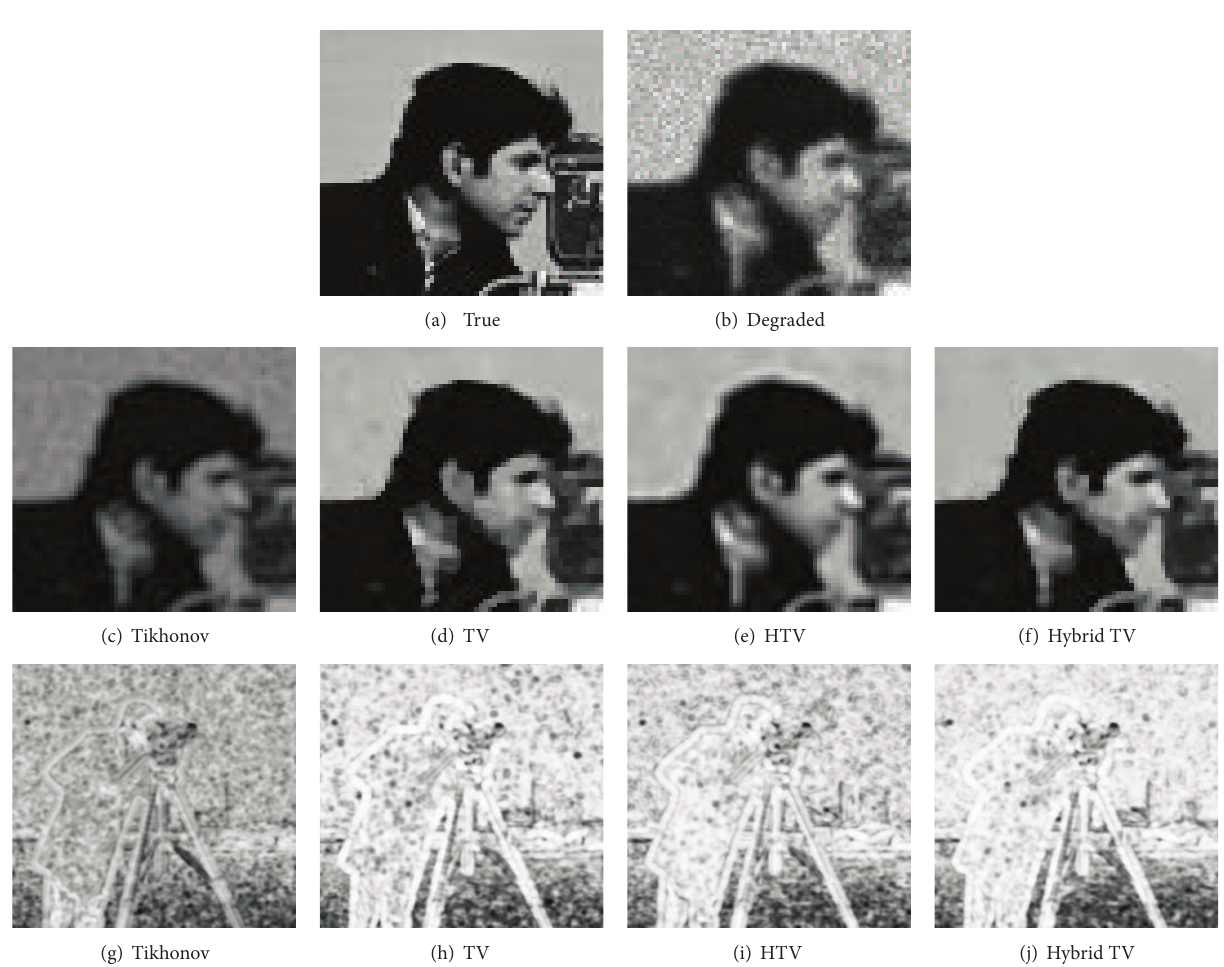
Figure 2: Comparison of a small portion of the restored images and SSIM maps for Example